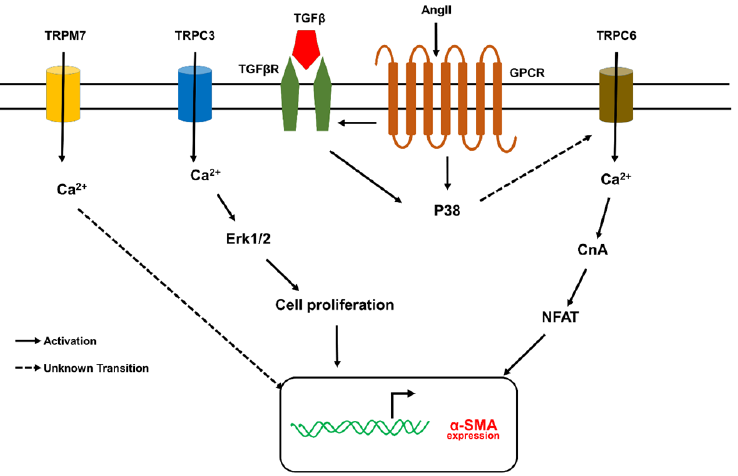
Figure 3. Schematic showing possible mechanisms by which TRP channels (other than TRPV4) regulate fibroblast differentiation. TRPC3, TRPC6, and TRPM7 have been implicated in fibroblast (atrial and ventricular) differentiation. TGF- β shown to influence the expression/activity of these three TRP channels. TRPC3 signaling demonstrated to be critical for atrial fibroblast proliferation, migration, and fibrosis. The possible signaling mechanism appears to be AngII/AT1R/TGF- β 1 mediated increase in TRPC3 expression via NFAT dependent downregulation of miR-26, which in turn activates fibroblast proliferation through ERK1/2. TGF- β was also shown to increase the expression of TRPC6 channels via p38/SRF and then calcium influx from TRPC6 induces fibroblast differentiation through CnA/NFAT signaling. TRPM7 shown to regulate mechanical stretch-induced fibroblast differentiation (atrial and adventitial) though p38 MAPK/JNK pathway. Ang II, angiotensin II; CnA, calcineurin; miR-26, microRNA26; NFAT, Nuclear factor of activated T-cells; ROCK, Rho associated protein kinase; SRF, serum responsive factor; α -SMA, α -smooth muscle actin; TGF- β , transforming growth factor β